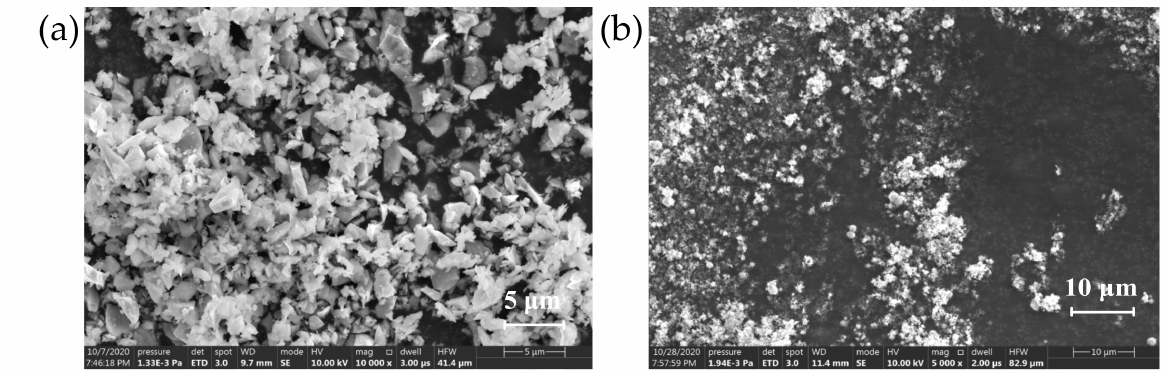
Figure 2. Electron microscope of SiC particles with different crystal types. ( a ) 10 µ m α -SiC; ( b ) 10 µ m β -SiC.